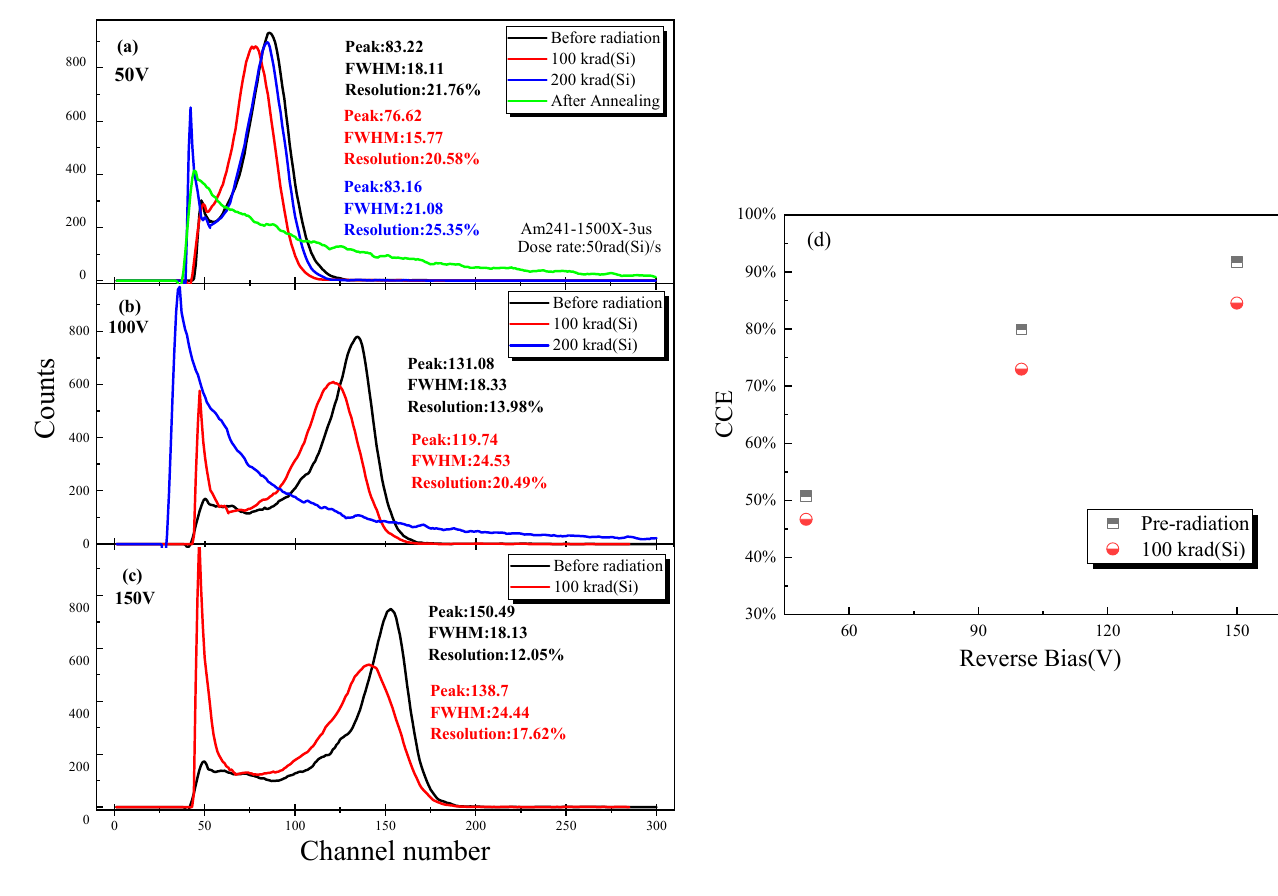
Figure 6. The γ ray spectra by the Schottky type CsPbBr 3 detector under a 241Am γ -source with different applied bias voltage before and after radiation. ( a ) − 50 V, ( b ) − 100 V, ( c ) − 150 V. ( d ) The calculated CCE is based on the spectra indicated in ( a – c ). The curve was smoothed by the Savitzky– Golay method.